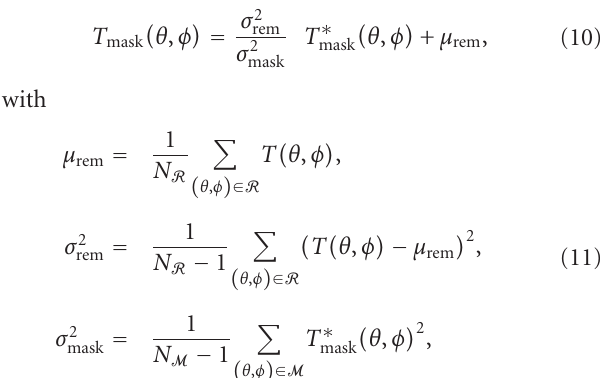
and variance σ 2 of the remaining regions of the original rem temperature